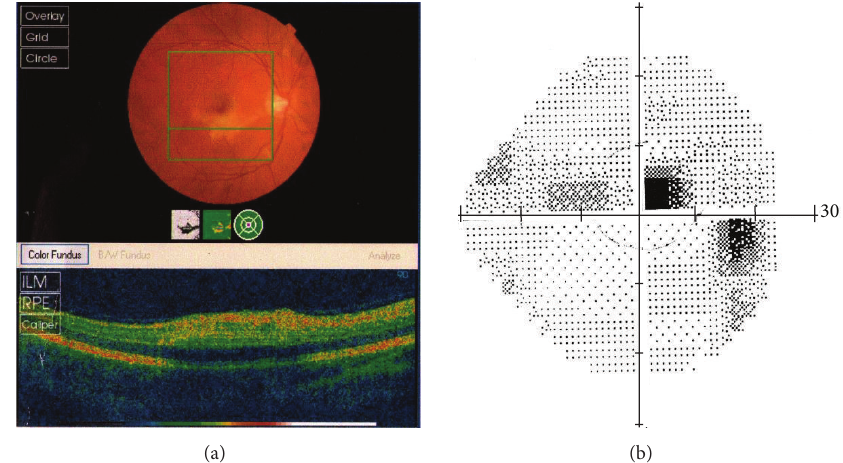
Figure2:Leftpanel:ocularcoherencetomography.Notethewideningoftheinnerretinallayersignifyingretinaledemathreeweeksfollowing admission. Right panel: right eye visual field. Note the central